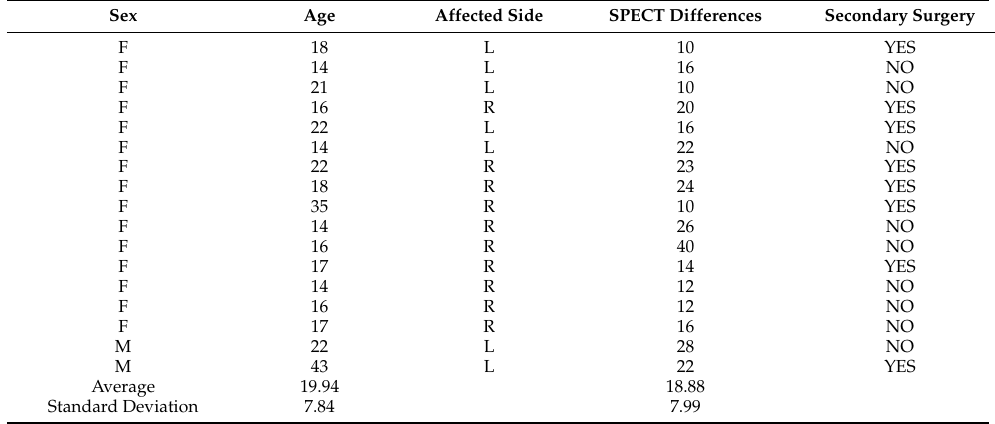
Table 4. Distribution of subjects with UCH according to clinical type